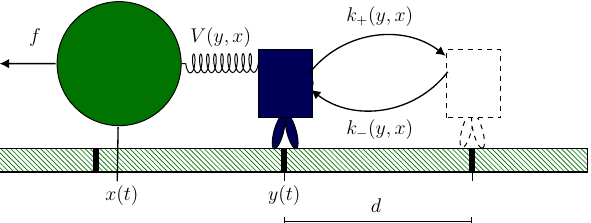
Figure 1. Illustration of the hybrid motor–bead model. The motor at position y ( t ) steps with step size d along a one-dimensional track in forward or backward direction with corresponding transition rates ( y , x ) . The bead at position x ( t ) is coupled to the motor via the potential V ( y , x ) and is subject to k ± an external force f